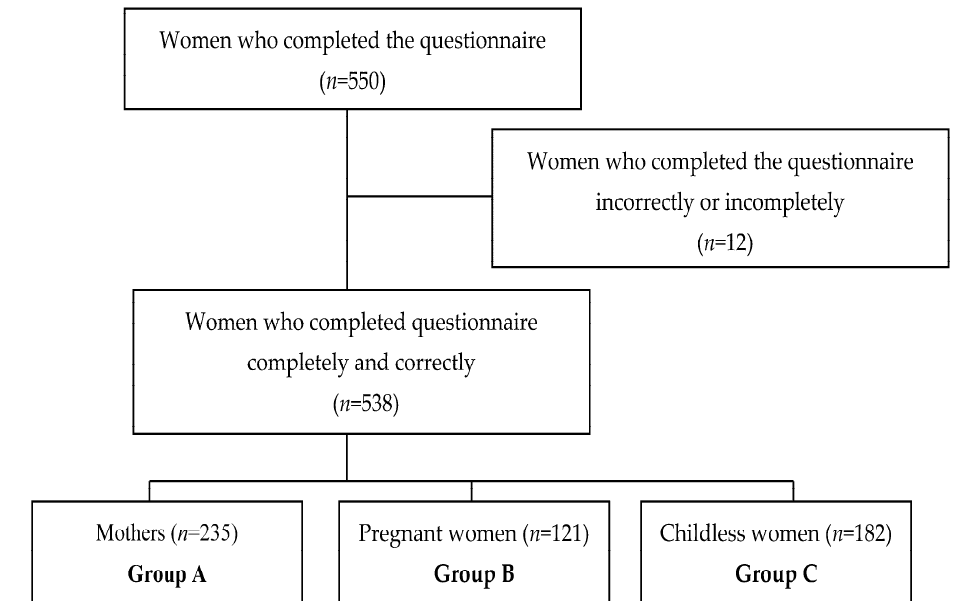
Figure 1. A flow ‐ chart demonstrating the selection of studied groups. Figure 1. A flow-chart demonstrating the selection of studied